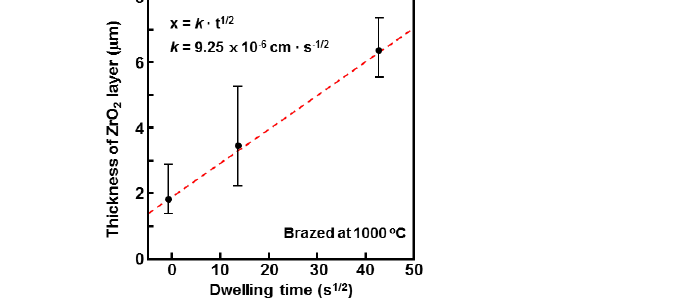
Figure 9. Thickness of ZrO 2 reaction layer (in μm) as a function of the dwelling time (s 1/2 ).